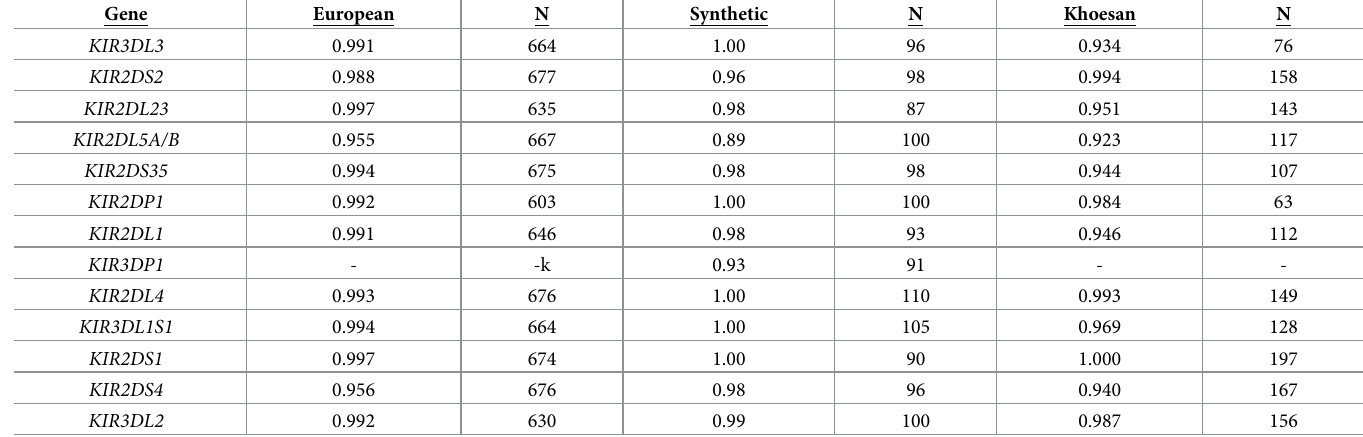
Table 3. Resolved genotype concordance. PING genotype determination performance for the European reference cohort, a synthetic KIR dataset, and the Khoesan refer- ence cohort for each considered KIR gene.